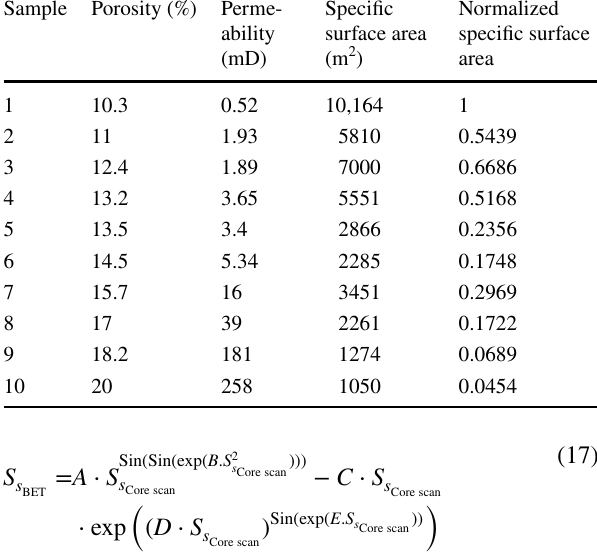
Table 14 Orenburg field carbonated samples properties (Evbuomwan 2009) Sample Porosity (%) Perme- ability